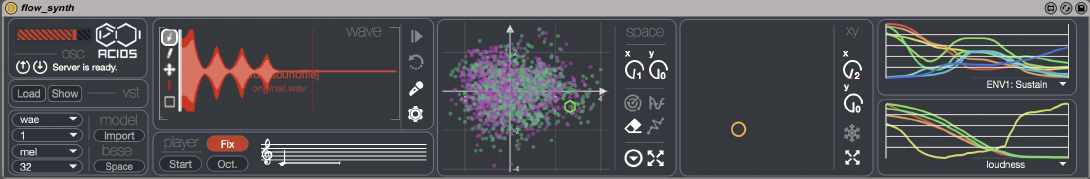
Figure 7. FlowSynth interface for audio synthesizer control in Ableton Live. The interface wraps a given VST, and allows to perform direct parameters inference, audio-based preset exploration and relying on both semantic and unsupervised macro-controls learned by our